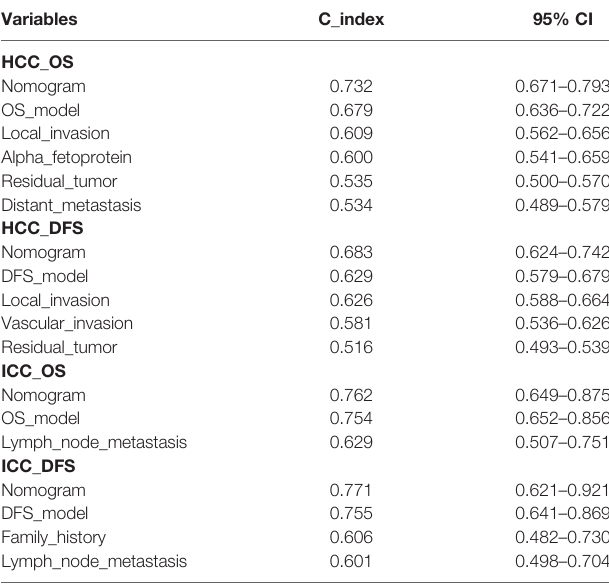
TABLE 3 | C_index of the nomogram model variables in HCC and